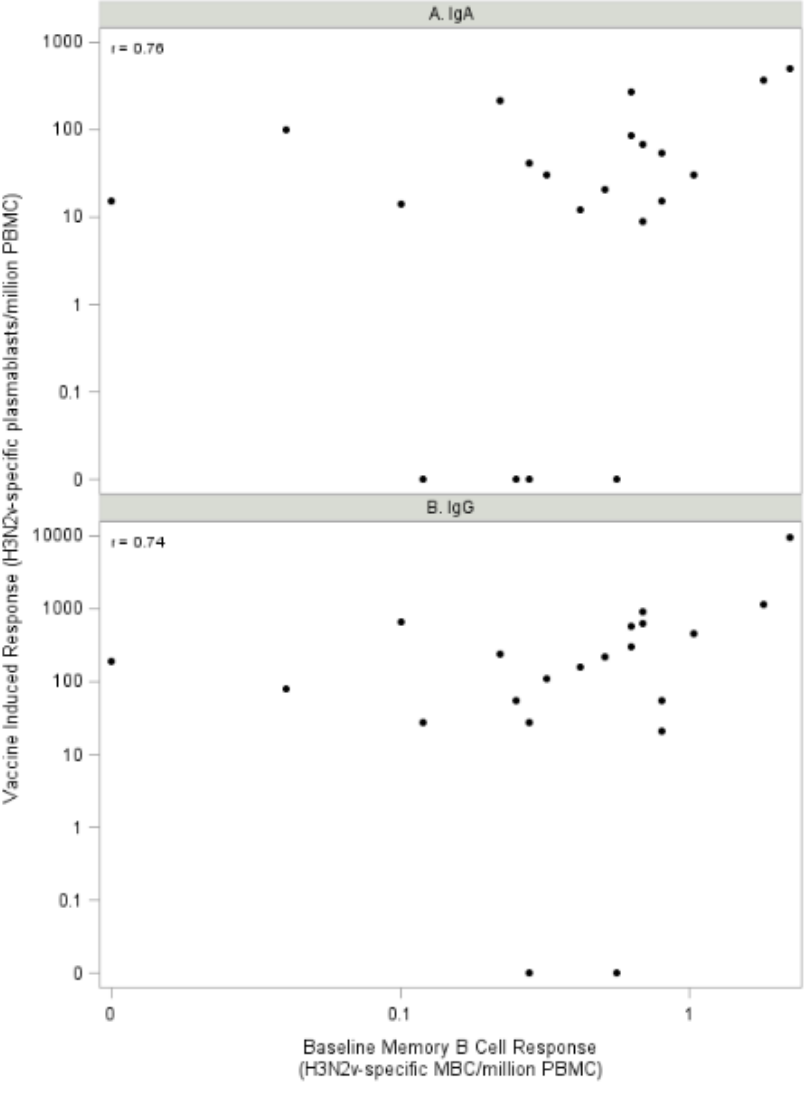
H3N2v-specific plasmablast response (A: IgA and B: IgG).